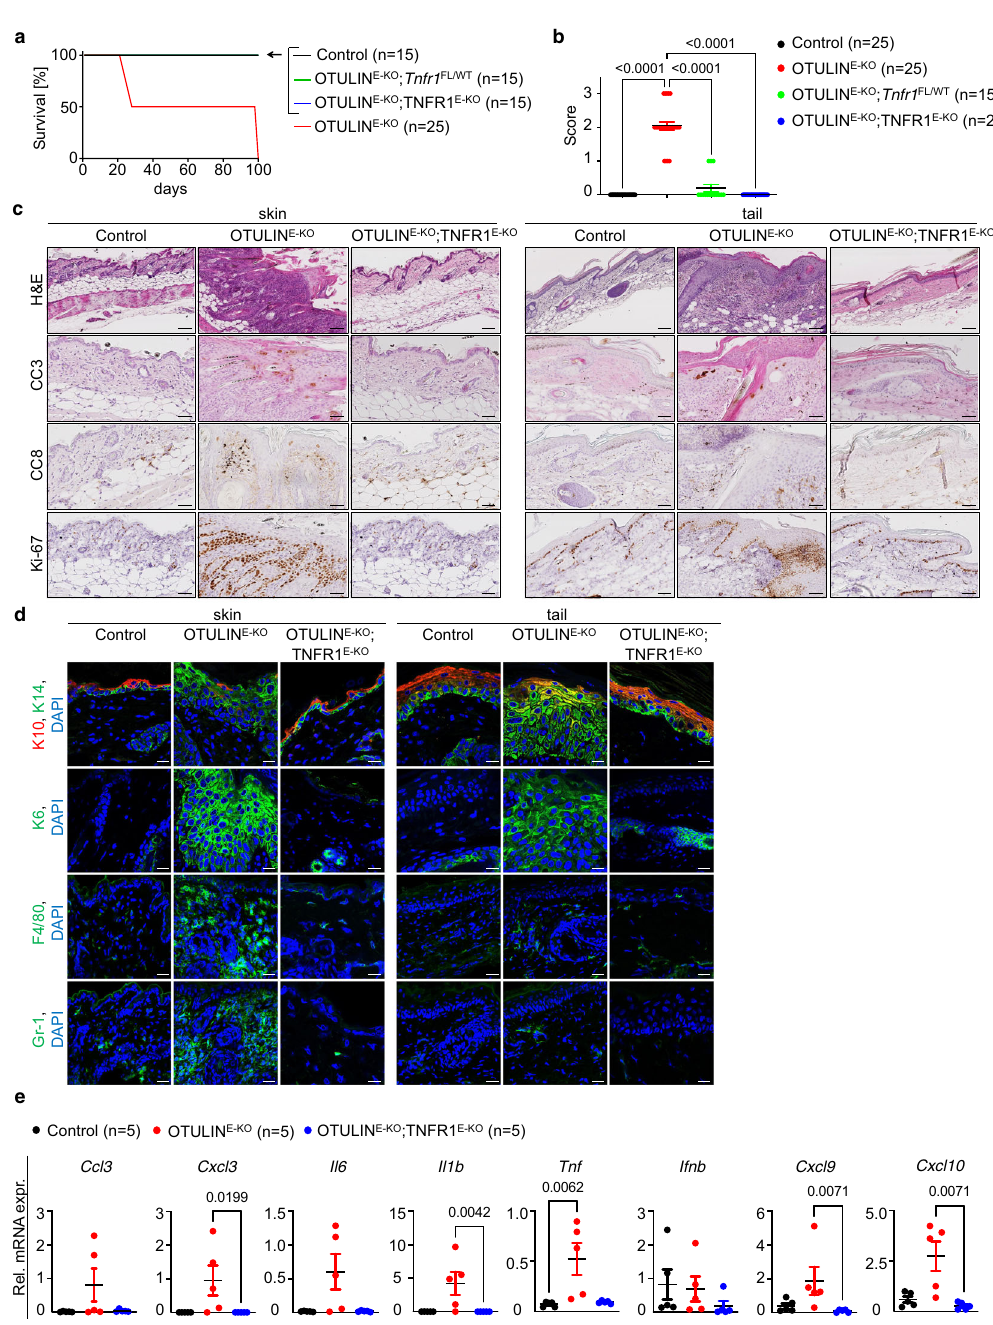
Fig. 2 TNFR1 signalling in keratinocytes causes skin in fl ammation in OTULIN E-KO mice. a Kaplan – Meier plot depicting survival of mice of the indicated genotypes. b Graph depicting macroscopic skin score of mice of the indicated genotypes. The dots in the graphs represent individual mice. Mean ± s.e.m. is shown for each group of mice in all graphs. Statistical signi fi cance was determined using Kruskal – Wallis test (one-sided). c Representative images of skin sections from 3-week-old mice of the indicated genotypes, stained with H&E ( n = 6) or immunostained with anti-CC3 ( n = 5), anti-CC8 ( n = 5) or anti-Ki- 67 ( n = 5) antibodies. Scale bars: H&E = 100 μ m; CC3, CC8, Ki-67 = 50 μ m. d Representative images of skin sections from 3-week-old mice of the indicated genotypes, immunostained with anti-K10, anti-K14 ( n = 5), anti-K6 ( n = 5), anti-F4/80 ( n = 3) and anti-Gr-1 ( n = 3) antibodies and counterstained with DAPI (DNA stain). Scale bars: K10, K14, K6 = 20 μ m; F4/80, Gr-1 = 30 μ m. e Graphs depicting relative mRNA expression of the indicated genes in RNA from whole-skin tissue of 3-week-old mice of the indicated genotypes, measured by qRT-PCR. The dots in the graphs represent individual mice. Mean ± s.e.m. is shown for each group of mice in all graphs. Statistical signi fi cance was determined using Kruskal – Wallis test (one-sided). Control mice include littermates that do not express K14-Cre . Source data for a , b , e are provided as a Source data fi